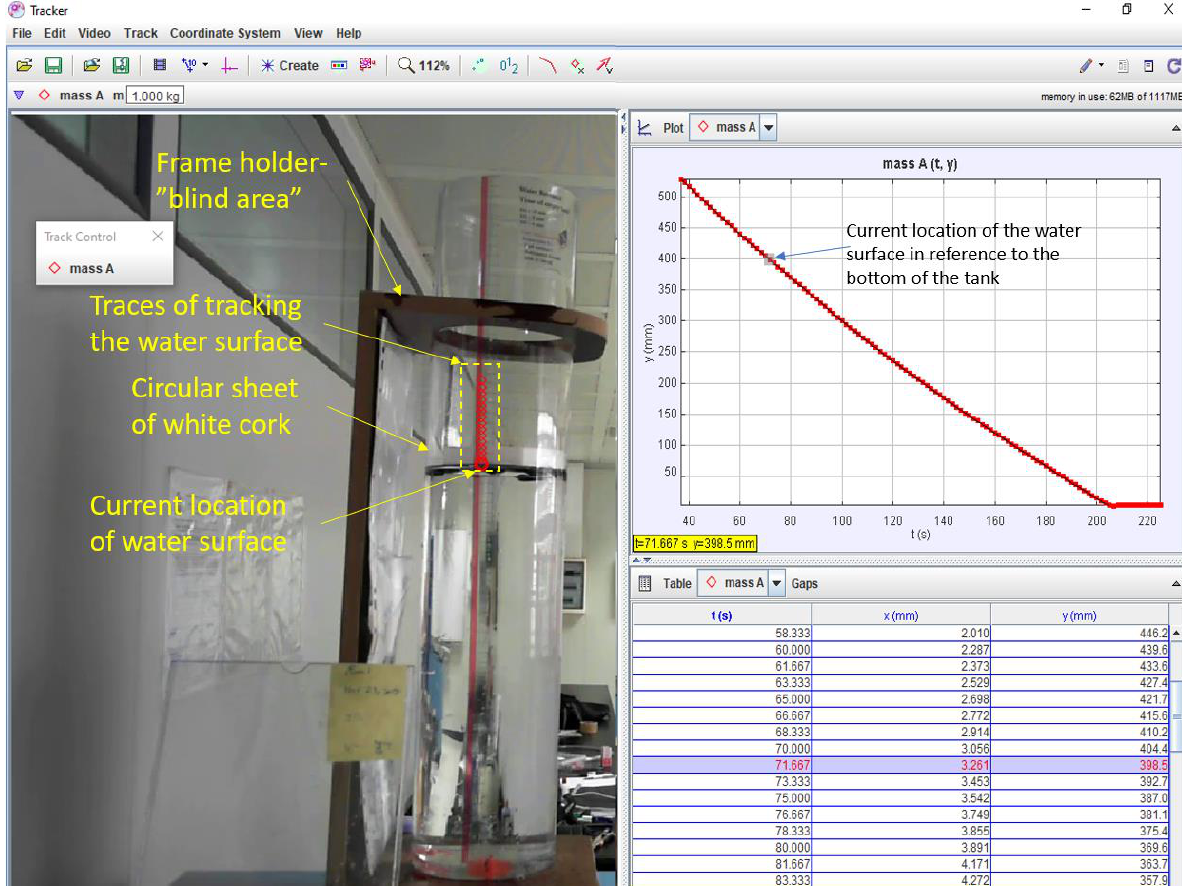
Figure 3. The process of auto-tracking the water surface in tank 1 via Tracker.